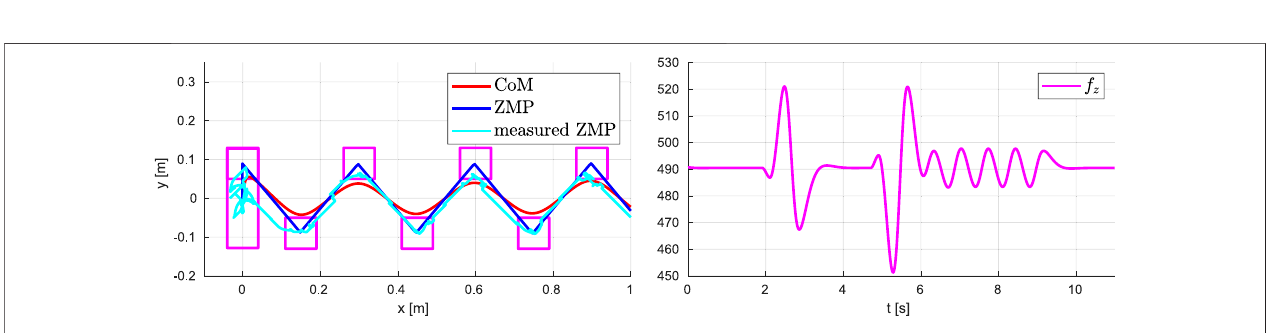
Frontiers in Robotics and AI |